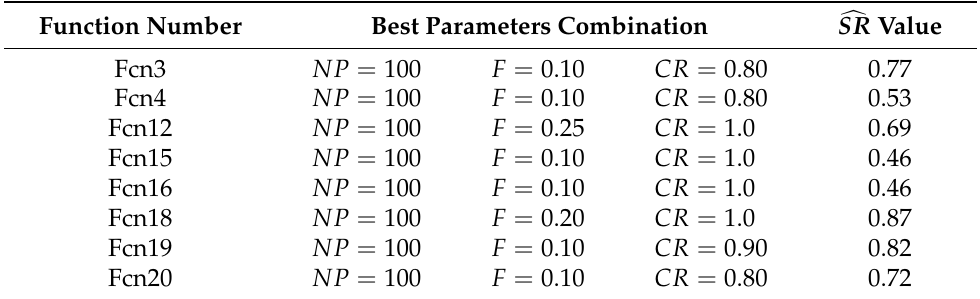
Table 5. The second case objective functions, their best parameter combination and the achieved (cid:99) SR value.